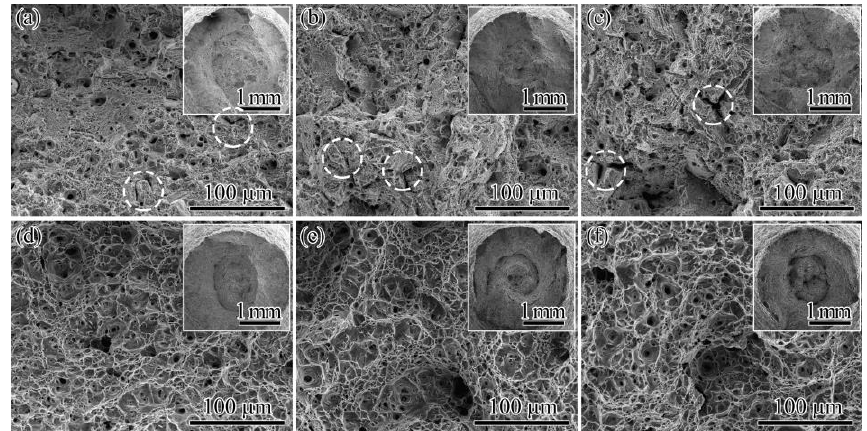
Figure 9. The SEM micrographs of ( a – c ) room temperature tensile fracture surfaces and ( d – f ) 650 ◦ C tensile fracture surface after aging at 850 ◦ C for 1000 h: ( a , d ) 15Cr–15Ni–Ti–70P alloy, ( b , e )